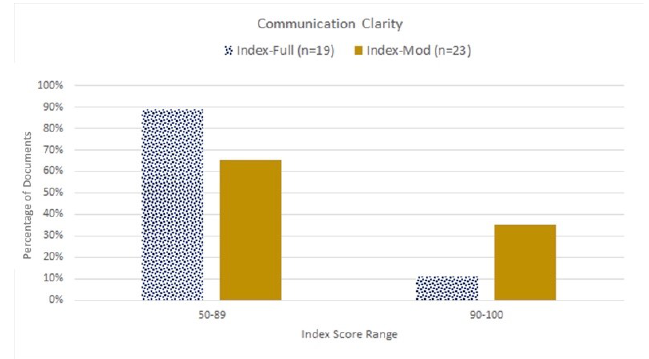
Figure 3 Clarity of communication materials as assessed by the Index. A score above 90% is considered passing or “easy to